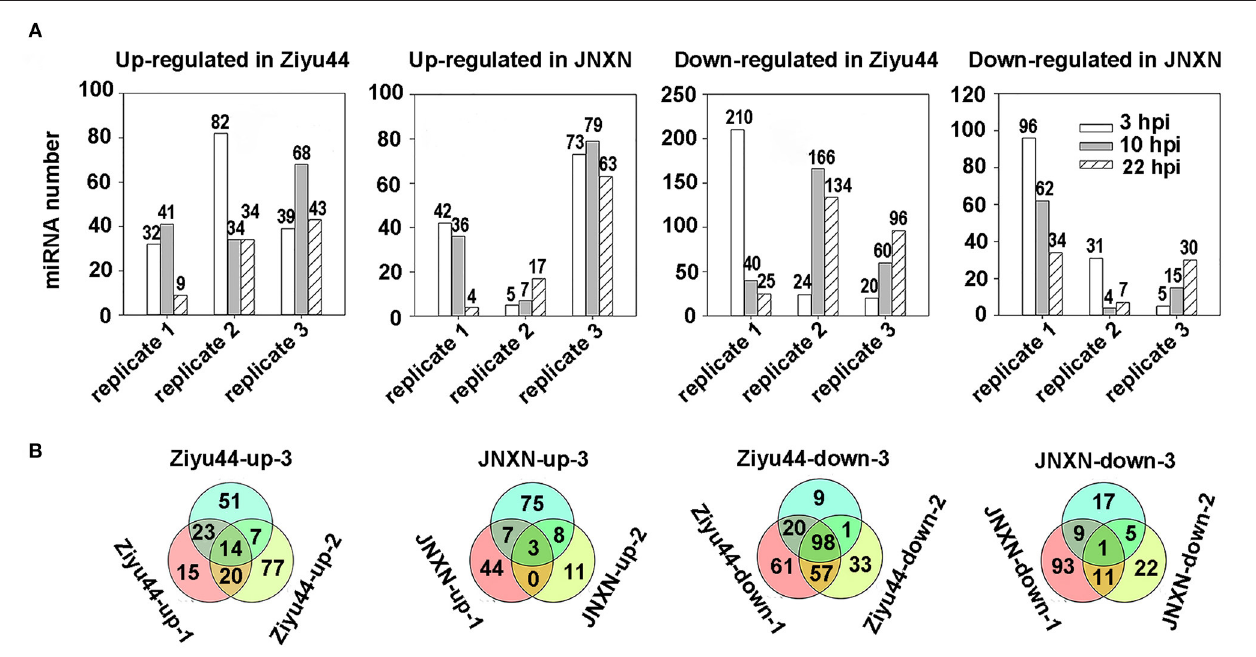
FIGURE 2 | Analysis of the differentially expressed miRNAs with a two-fold variation. (A) Bar charts summarizing the number of differentially expressed miRNAs (treat/mock ≥ 2 or treat/mock ≤ 0.5) in Ziyu44 and JNXN at every time point after being infected with M. oryzae . replicate 1, replicate 2, replicate 3 represents the three biological replicates performed three times under similar conditions. (B) The number of overlapped means differentially expressed miRNAs in Ziyu44 and JNXN among the three biological replicates. “Ziyu44-up-1” represents the number of all miRNAs upregulated at 3, 10, and 22 hpi in biological replicate 1, and so